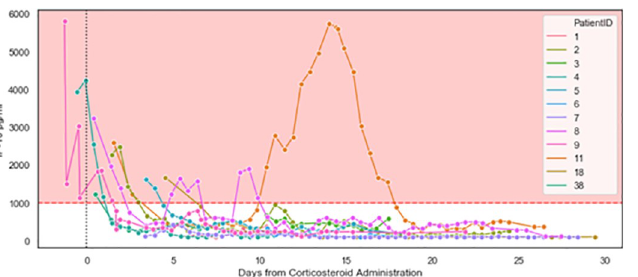
Fig 4. Initiation of corticosteroid therapy resulted in a decrease in IP-10 levels (ICU patients, n = 12). IP-10 was measured at the indicated time points during ICU stays. Day 0 indicates initiation of corticosteroid therapy. The pink area indicates IP-10 levels exceeding 1,000 pg/mL. Patients 2, 8, and 11 exhibited subsequent surges in IP-10 levels and are detailed in Fig 5. Of note, at study initiation, some patients were studied who were already hospitalized in the wards and ICU. Corticosteroid treatment was not initiated prior to hospitalization. From the point of patient selection, every measurement taken is included in the